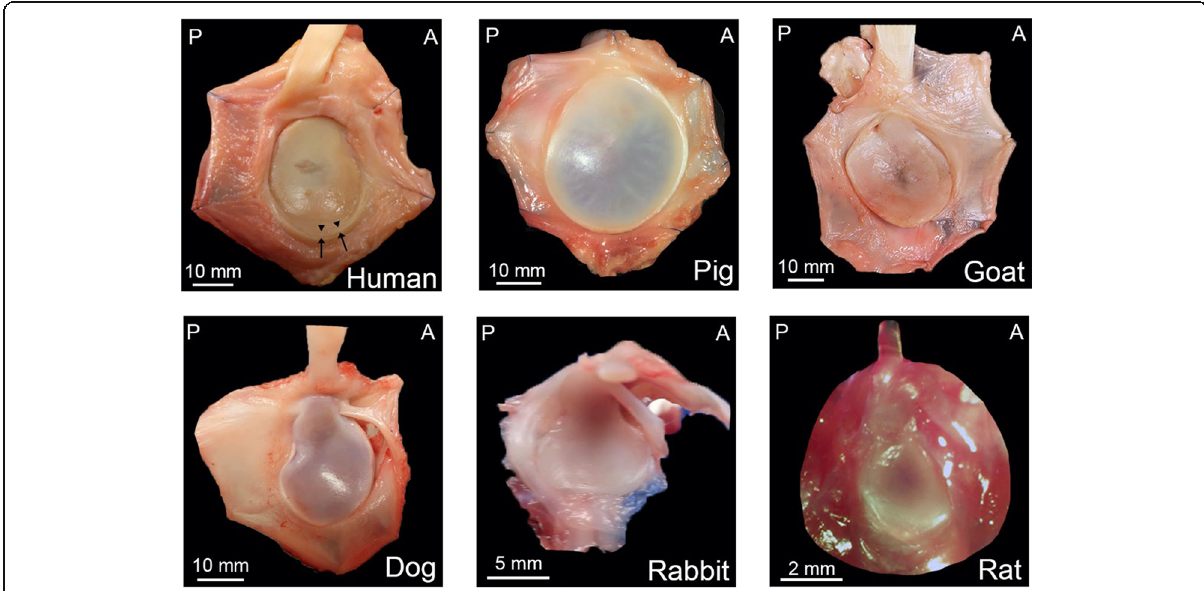
Fig. 1 Gross anatomy of the glenoid with attached capsulolabral complex. Anterior (A) on right, posterior (P) on left, in each panel. Superior is top of panel, with 12 o ’ clock position indicated by the inserting long head of biceps. Glenolabral and capsulolabral junctions in the human shoulder indicated by arrowheads and arrows, respectively; absent in other animals